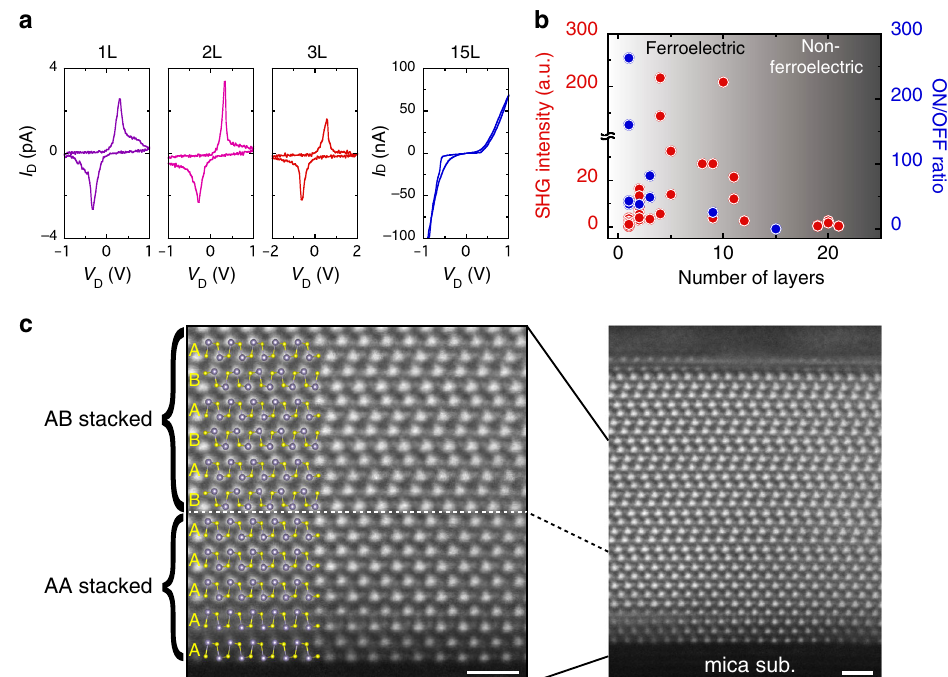
Fig. 5 Transition of stacking sequence from AA to AB staking. a Ferroelectric resistive switching for SnS with different thicknesses: monolayer, bilayer, trilayer, and 15 L. b Thickness dependences of the SHG intensity and ON/OFF ratio for different thicknesses. The ON/OFF ratio was determined at the coercive electric fi eld of I D – V D for Ag/SnS device. Each data points of SHG and ON/OFF ratio represent an individual SnS crystal. c Cross-sectional HAADF-STEM image of 16 L SnS along the armchair direction. The scale bars represent 1